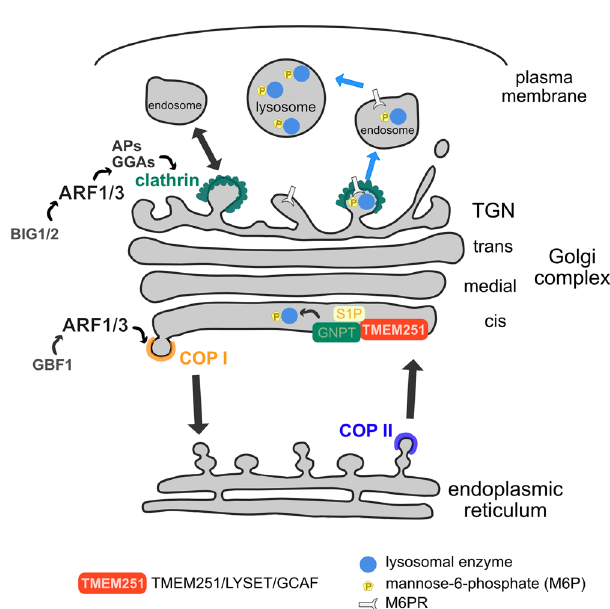
Fig. 1 | ARF1/3 are involved in the formation of carrier vesicles and LYSET is involved in the targeting of lysosomal enzymes. At the Golgi complex, ARF1/3 mediate the recruitment of coat proteins to give identity to the transport carriers. Atthe cis -Golgiand TGN,ARF1/3recruit COP I and clathrin, respectively. TMEM251 is a Golgi protein required to add the mannose-6-phosphate (M6P) group on lysosomal enzymes, ensuring their proper addressing to the lysosome.